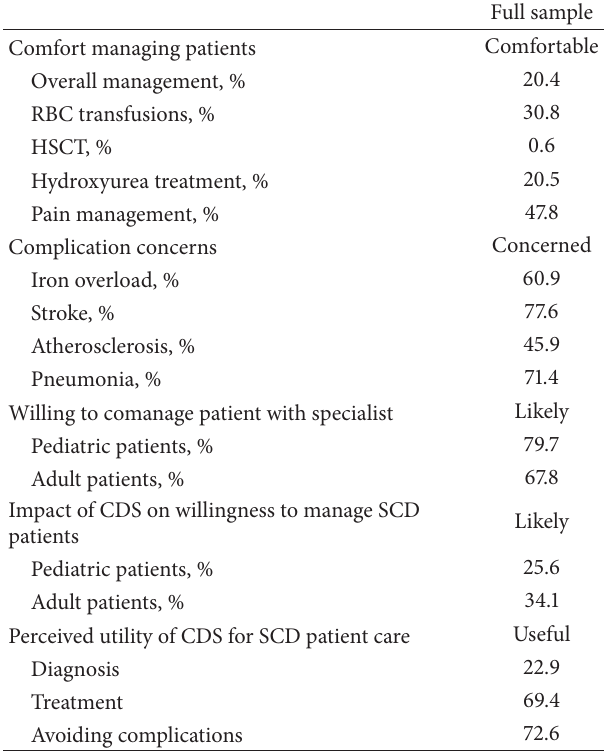
Table 2: Physician perceptions of SCD, full